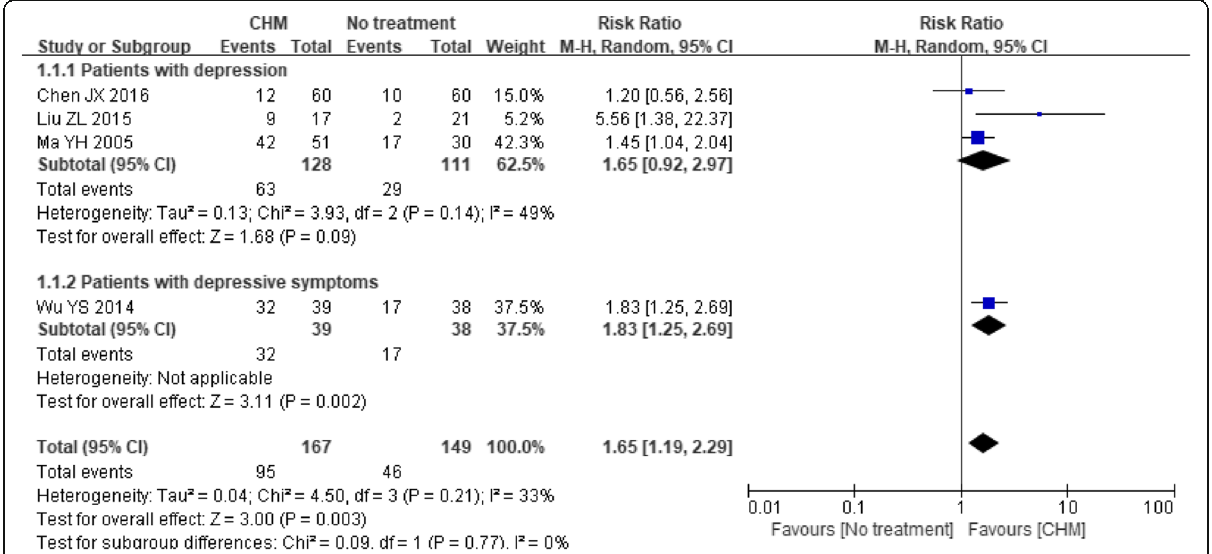
Fig. 6 Forest plot of depression treatment response rate for CHM versus no